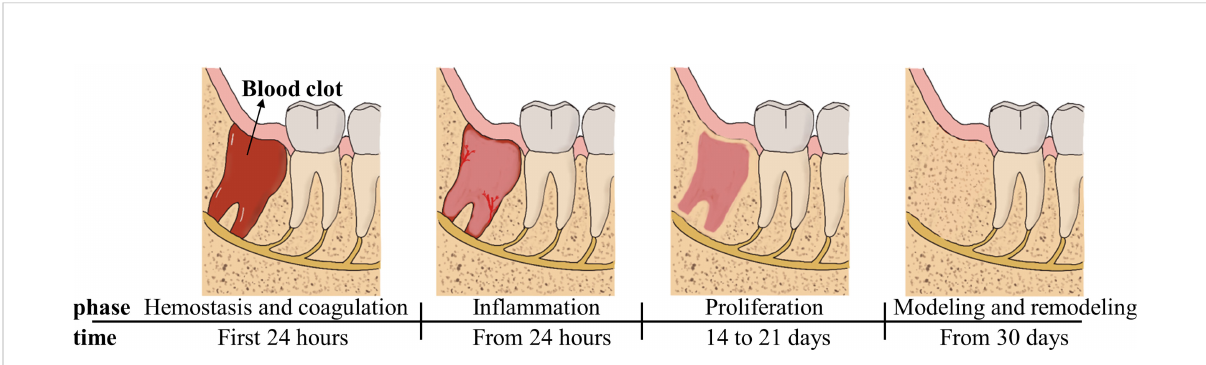
FIGURE 1 Main processes of wound healing occurring in the socket after tooth extraction depicted as four time-related